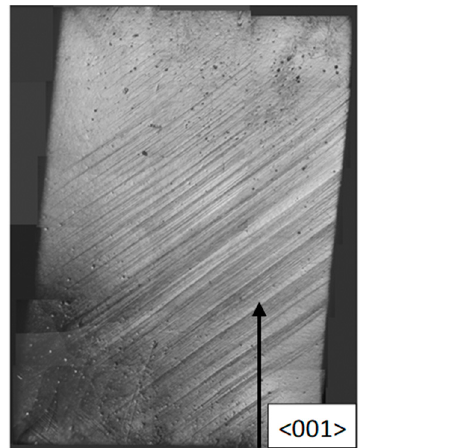
Figure 16. Deformation patterns on {100} lateral faces of a <001> Ni single crystal with h/d = 1; ε = 13%. 5. Discussion The MD simulations showed that shear starts simultaneously at all vertices of the sample, which are the sites of stress concentration. The scheme of partitioning samples with different height-to-width ratios into domains depends largely on the geometry of positioning these basic stress concentrators. The simulation results were obtained for a case very close to the equiprobable shear starting at all eight concentrators. This ideal shear is difficult to realize in experiments because of failure to comply with the condition of the equiprobable shear along all four equiloaded planes, which can be caused by even small deviations in face parallelism or compression axis alignment. This is the main origin of the difference between the deformation patterns obtained in the experiments and MD simulations. The results of the present and previous works exhibit that deformation patterns depend on local stress conditions and the possibility of shear deformation in the bulk of a single crystal. Shear deformation near the punches of the testing machine is constrained, while it can propagate towards the lateral faces. This is justified by the simulation results. MD simulation makes it possible to estimate which dislocations are formed depending on the material (Ni or Al), crystallographic conditions (orientation of lateral faces) and sample geometry (various height-to-width ratios). The following findings can be drawn from the analysis of these factors performed using the data on fractions of different dislocations in Ni and Al samples listed in Table 1. The presented results indicate the following: